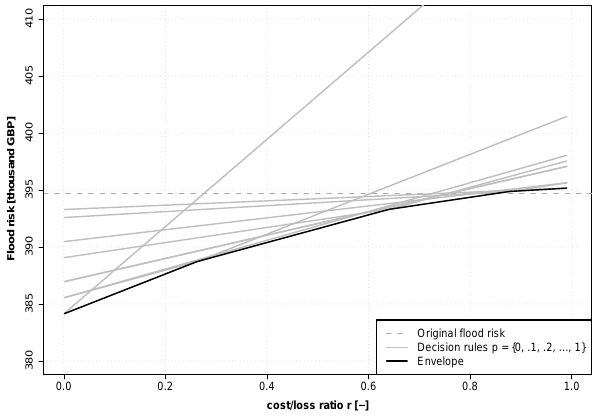
Fig. 9. Flood risk as a function of cost-loss ratio for decisions based on probabilistic forecasts with a 3-h lead-time. The grey lines cor- respond to the values of flood risk for each of the decision rules P ≥ 0, 0.1, 0.2, ... , 1 (from bottom upwards panels). The black line is the envelope of these